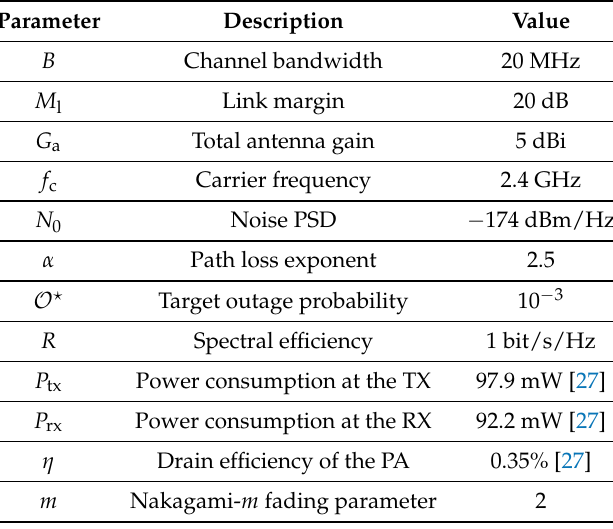
Table 2. Simulation